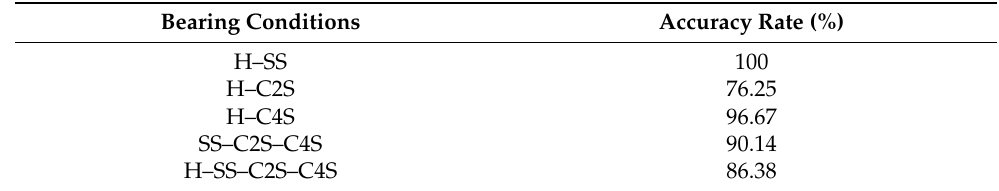
Table 3. Diagnosis results for concentrated scratch faults.